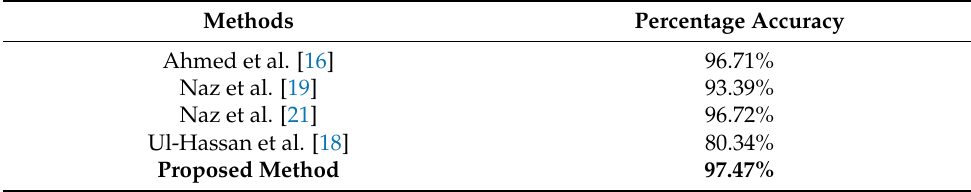
Table 8. Accuracy